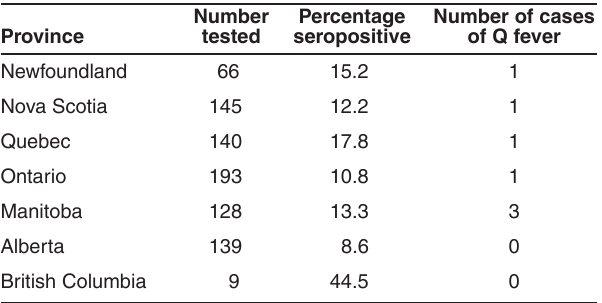
TABLE 2 Number and percentage of 788 patients who had the indicated antibody titres to phase I and phase II Coxiella burnetii